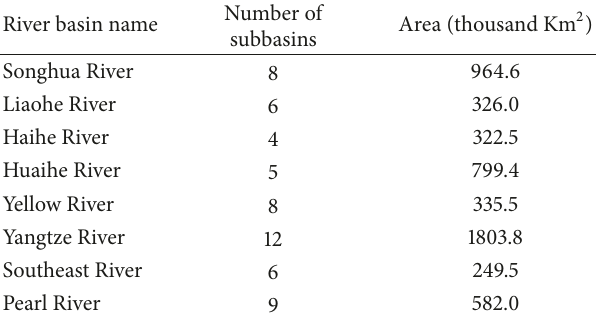
Table 1: Summary of eight first level basins of eastern